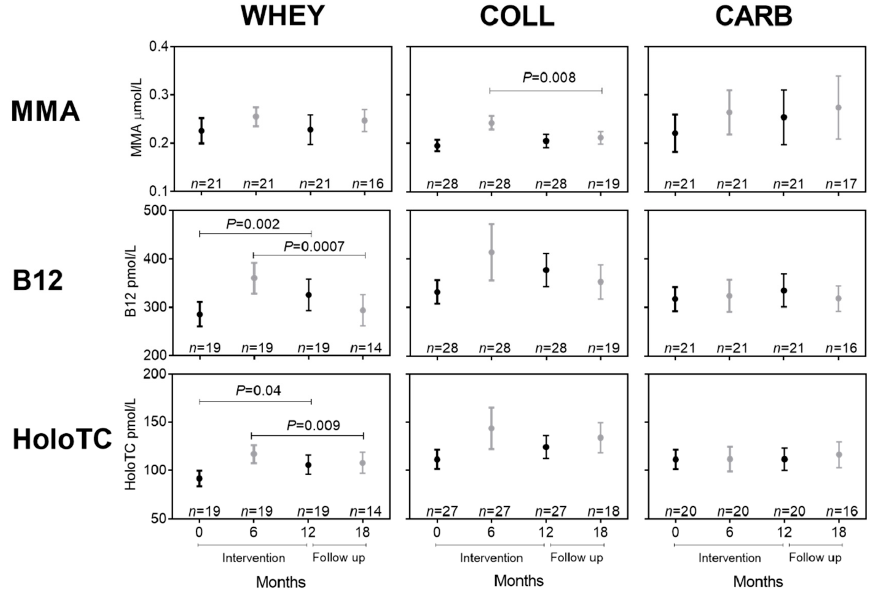
Figure 2. Changes in markers of B12 status in response to nutritional intervention. Healthy older participants received 1 year of intervention with whey (WHEY), collagen (COLL), or carbohydrate (CARB) with no additional training. Plasma concentrations of MMA, B12, and holoTC at baseline and after six months (6 mo) and 12 months (12 mo) of intervention and again after a six months follow-up period (18 mo) are shown as means with their standard errors. The number of observations is indicated ( n = x). Plasma samples were obtained in the overnight fasted state at baseline and 12 mo (black symbols), where the nutritional state was not controlled at 6 mo and 18 mo (grey symbols). Therefore, the statistical comparisons are made pairwise within each of the states, and the statistical differences between fasting blood samples (baseline vs. 12 mo, black) and between non-fasting blood samples (6 mo vs. 18 mo, grey) were estimated with the paired t-test or the Wilcoxon signed-rank test (non-normal data). Abbreviations: B12, vitamin B12; holoTC, holotranscobalamin; MMA, methylmalonic acid.